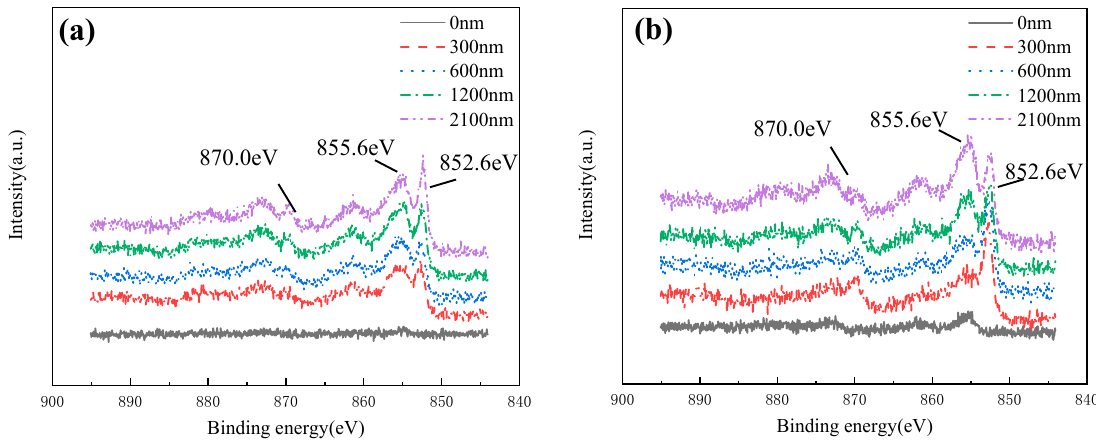
Figure 20. Ni 2p XPS spectra of HAZ corroded in flowing seawater: ( a ) 3 m/s, ( b ) 5 m/s. Cu 2p at different depths of corrosion production is shown in Figure 21. A small amount of Cu (II) (2p 3/2 peak binding energy ~934.5 eV) existed in the out layer. In the depth ranging from 300 nm to 2100 nm, Cu mainly existed in the form of Cu (I) (2p 3/2 peak binding energy ~932.6 eV, 2p 1/2 peak binding energy ~953.2 eV). Combined with Raman spectral data analysis, Cu (I) and Cu (II) existed in the forms of Cu 2 O and Cu 2 (OH) 3 Cl, respectively. Cu 2 (OH) 3 Cl was the main composition of out layer production, while the inner layer was mainly Cu 2 O.